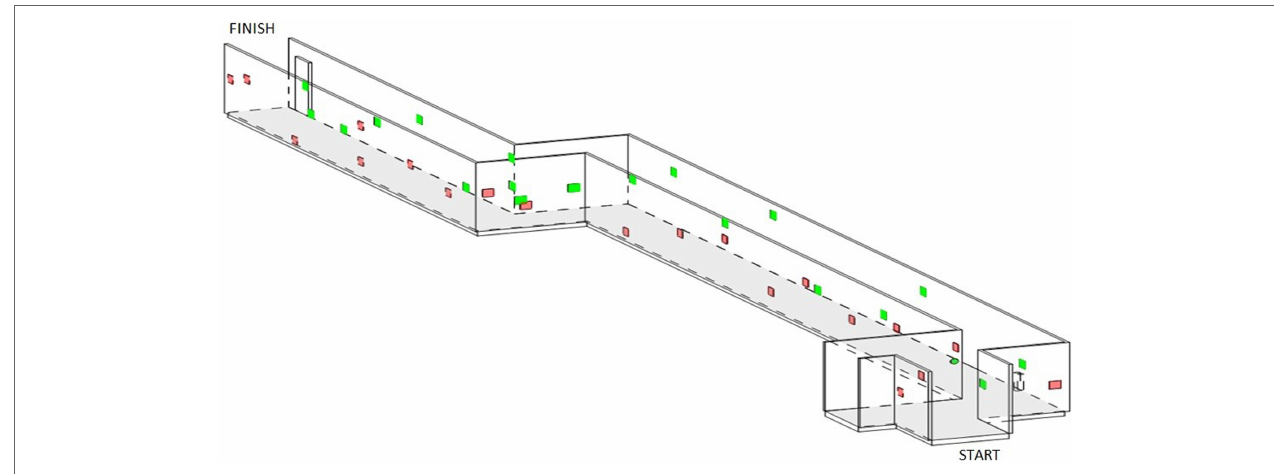
FigUre 1 | A schematic 3D model of the Mobility Assessment Course situated at Guide Dogs of SA/NT. Red targets are corresponding to the left wall. Green targets are corresponding to the right